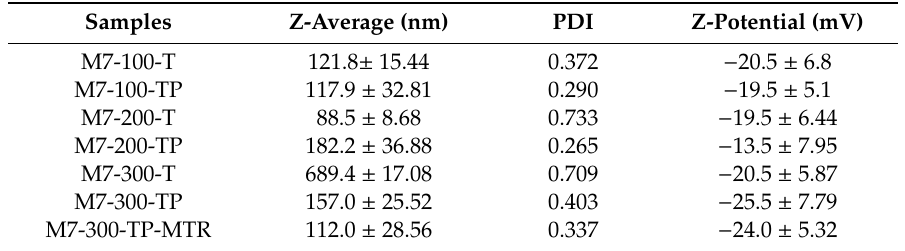
Table 3. Mean particle size (Z-average), particle size distribution (PDI), and electrical charge surface (ZP) of NLC formulations. Values are expressed as mean ± SD ( n =